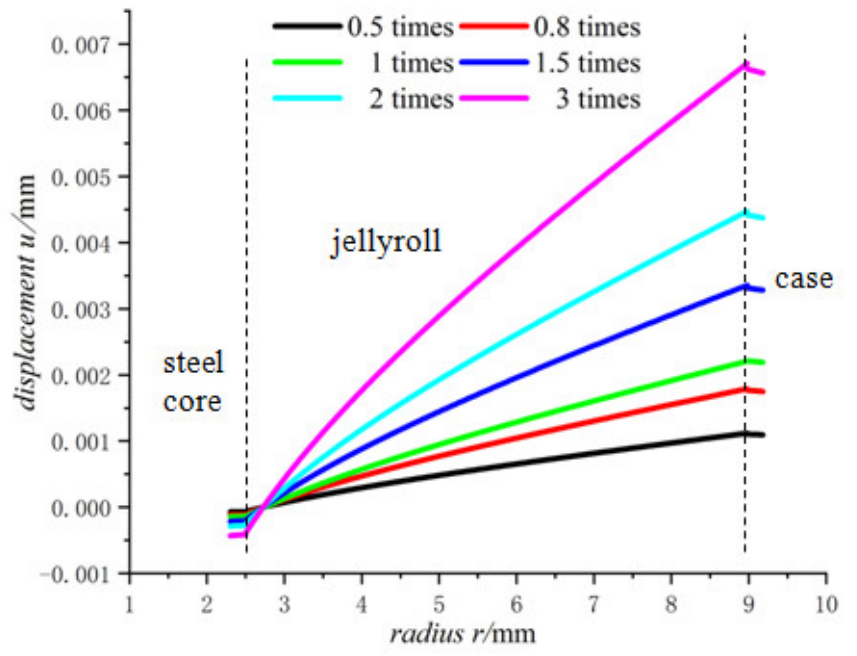
Figure 10. Displacements of 18650 battery at different lithium-ion concentrations.